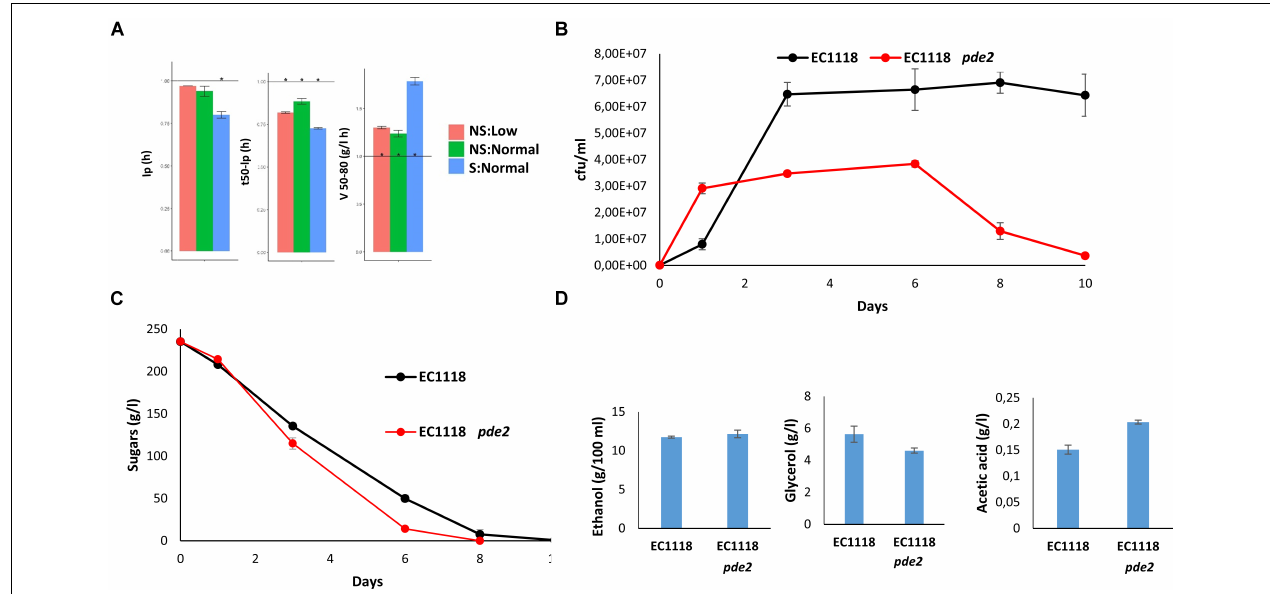
FIGURE 7 | cAMP phosphodiesterase PDE2 deletion increases fermentation speed. (A) Normalized values of the lag phase (lp), t50-lp, and V50-80 of mutant pde2 (cid:49) in relation to parental strain C9. Fermentations were carried out in triplicate, and average and standard deviations are shown. Significant differences ( p < 0.05) are marked by *. (B) Cell growth measured as CFU during the red grape juice fermentation of strains EC1118 and EC1118 pde2 (cid:49) . (C) Reducing the sugar consumption of the fermentations depicted in (panel (B) ). (D) Ethanol, glycerol and acetic acid production after completing these fermentations. Experiments were performed in triplicate, and average and standard deviations are